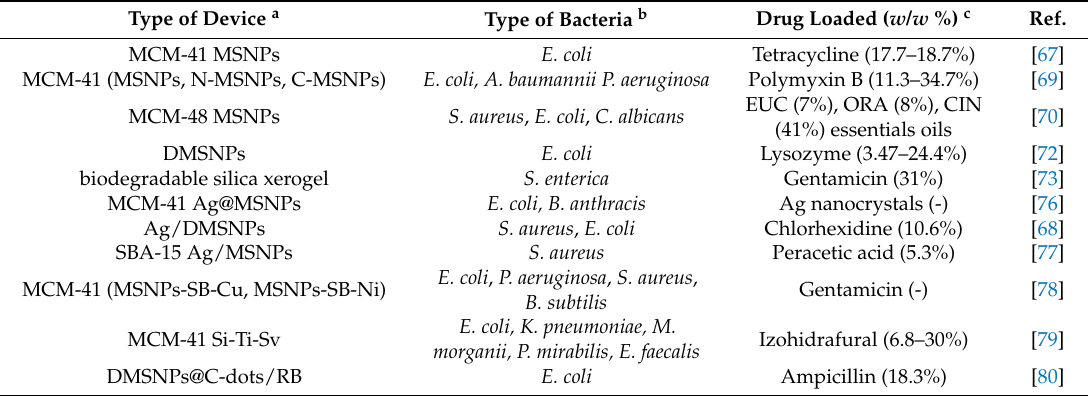
Table 1. Mesoporous Silica Materials in the Treatment of Planktonic